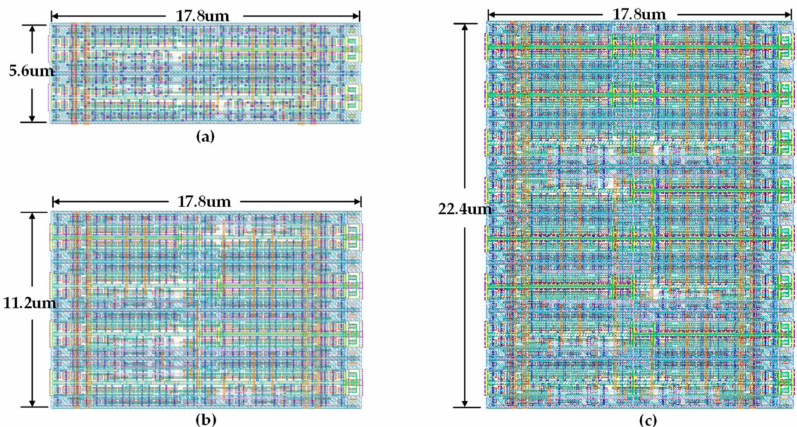
Figure 5. ( a ) Layout of the proposed 8 bit CSLA; ( b ) layout of the proposed 16 bit CSLA; ( c ) layout of the proposed 32 bit CSLA.